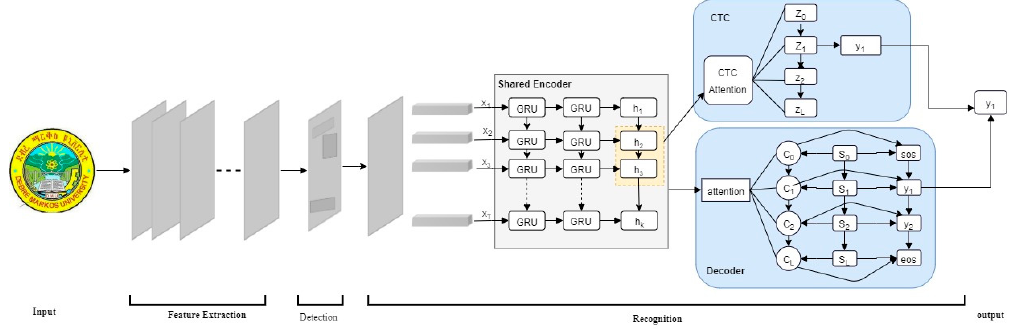
Figure 1. The architecture of the proposed bilingual end-to-end scene text reader model.